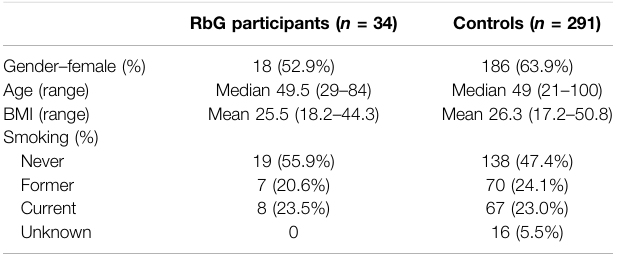
TABLE 2 | Cohort characteristics. RbG, recall-by-genotype; BMI, body mass index.